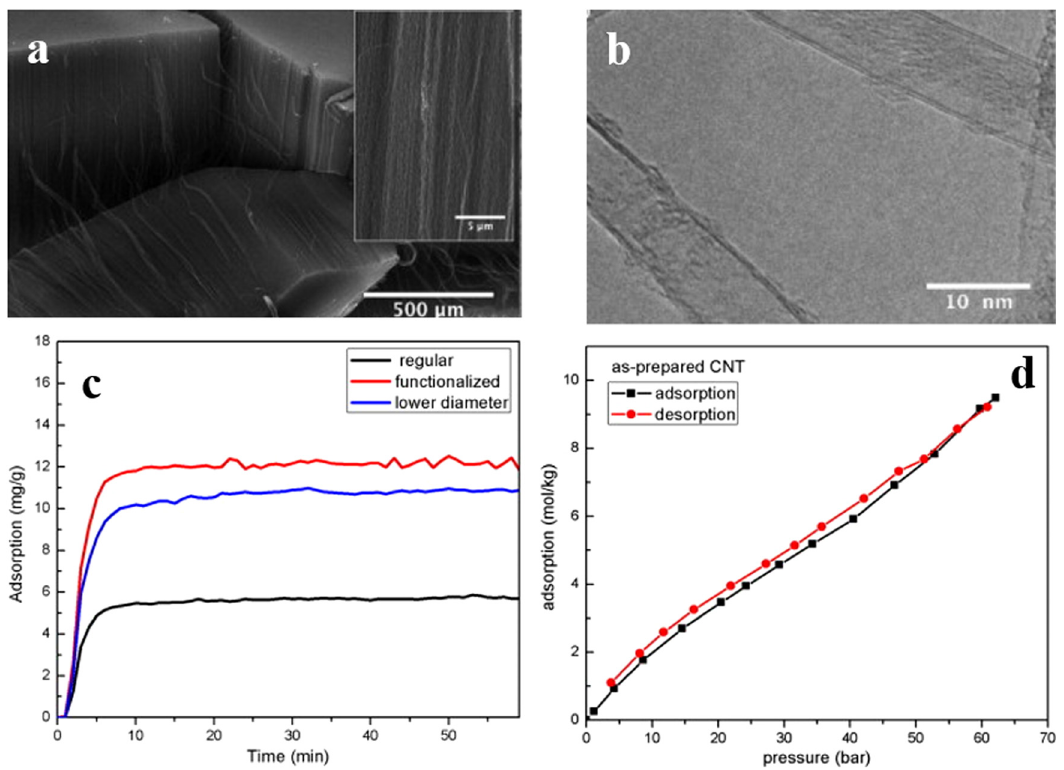
Figure 17: ( a ) SEM image of 3D VACNT. Inset shows the vertically aligned, highly parallel CNT morphology. ( b ) TEM image of individual VACNT. ( c ) Dynamic CO 2 adsorption researches at 1 atm, 308 Kelvin under di ff erent conditions. ( d ) High pressure CO 2 adsorption char - acteristics of VACNT under di ff erent conditions [ 132 ] . Copyright 2013,